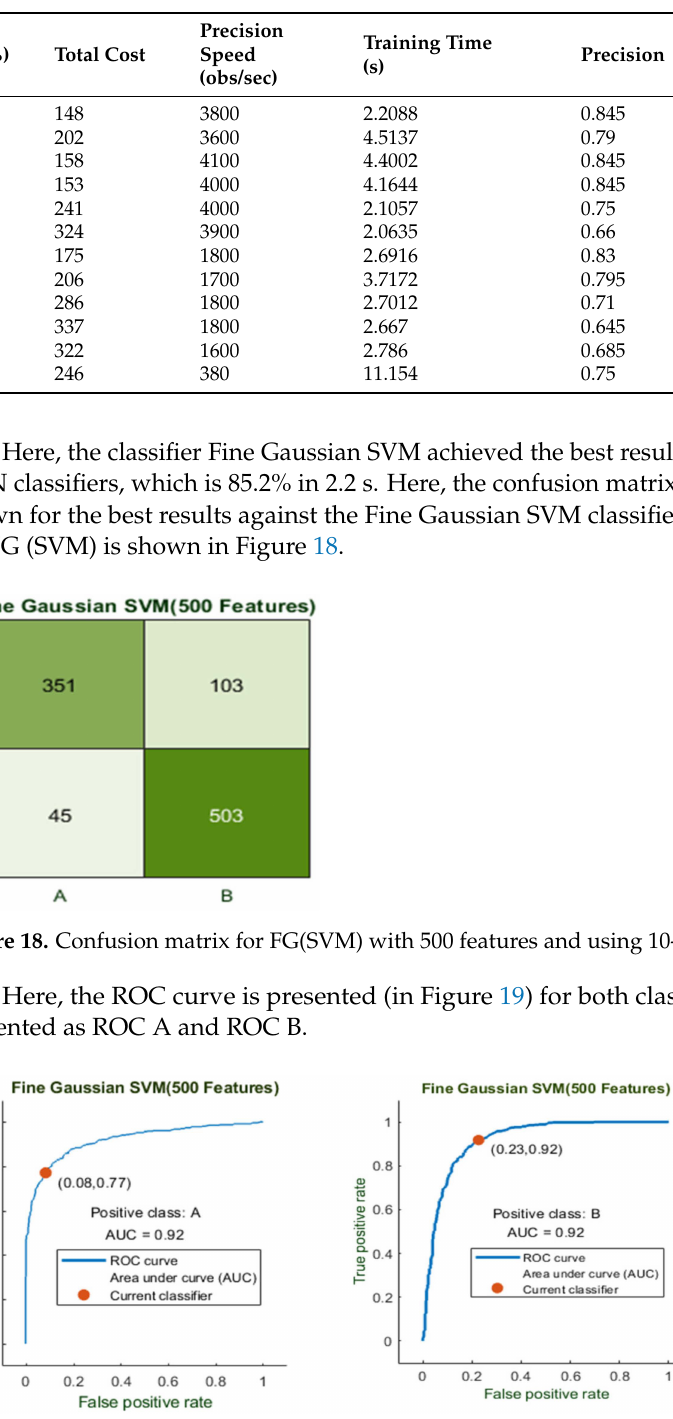
Table 9. Experiment_3 using 10 Folds (500 Feature).